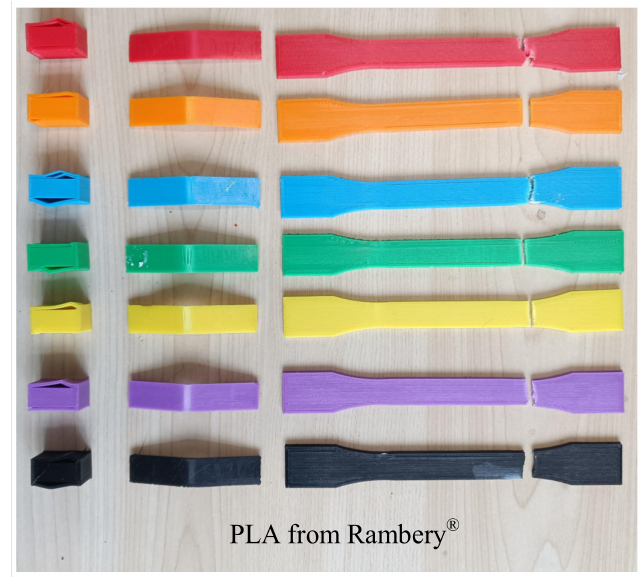
Figure 10. Broken PLA specimens from Rambery ® after confirmation test.